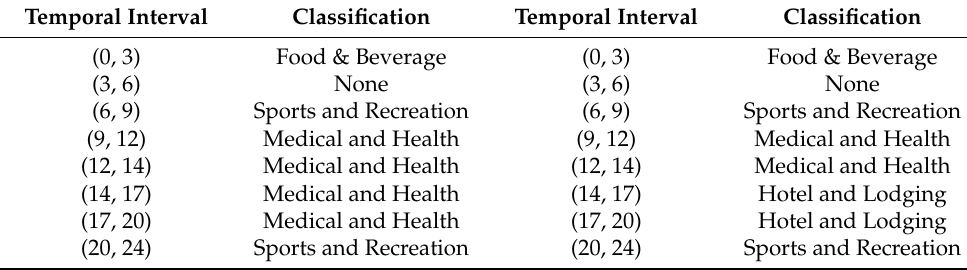
Table 5. Region classification by type of day and time interval.